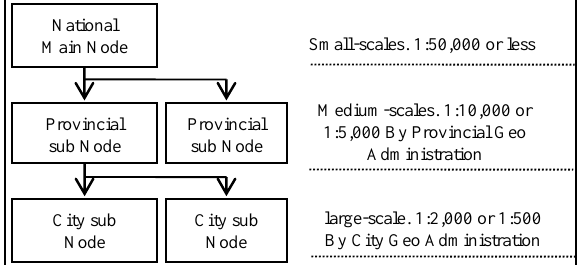
Figure 2. The Datasets organization structure of Chinese NSDI There are two main classifications of Chinese NSDI data which are parts of China fundamental geoinformation datasets. The two classifications are Coordinate Reference Datum datasets and Multi Scales Fundamental datasets. Coordinate Reference Datum datasets contains 33 A-class GNSS points and 818 B- class GNSS points, which forms the China geospatial information reference network, and the gravity control network which contains 137 gravity reference points (18 fiducial points and 119 basis points) (Deren Li, 2002). All these infrastructures formed the unique, high precision and stable geomatics reference framework. The Multi Scales Fundamental datasets scaled from 1:1million to 1:10,000, and some areas such as the city centre of Shanghai, Tianjin and Beijing partly covered by